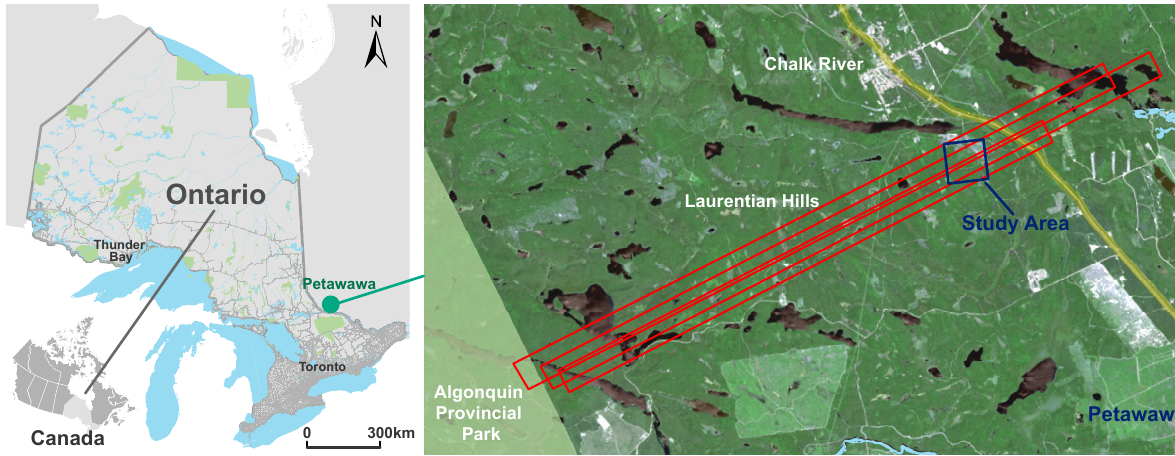
Figure 1. Study area and multispectral LiDAR data strips.